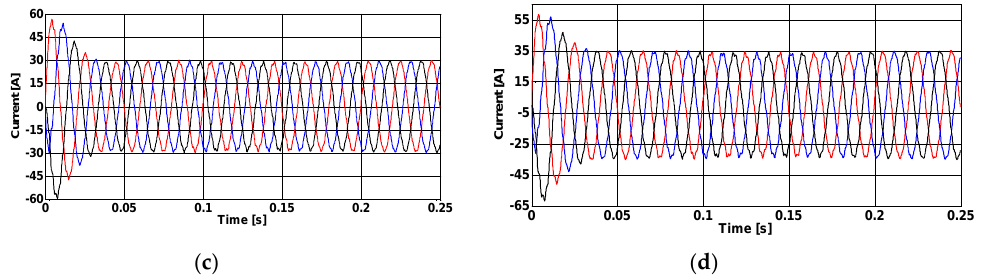
Figure 13. Variation of the currents on the three phases vs. time in the starting process of the ZAIM for different values of the eccentricity: ( a ) e = 0 mm; ( b ) e = 0.5 mm; ( c ) e = 1 mm; ( d ) e = 1.5 mm.